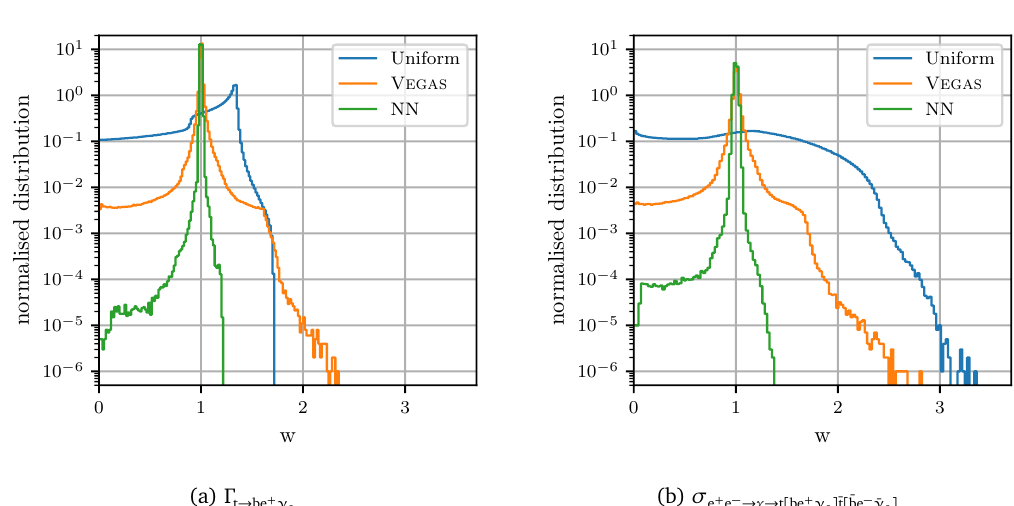
Figure 2: Event weight distributions for sampling the partial decay width Γ and the total cross section σ for e + e − → γ → t [ be + ν each with N = 10 6 points, comparing V EGAS optimisation, NN-based optimisation and an unoptimised (“Uniform”)